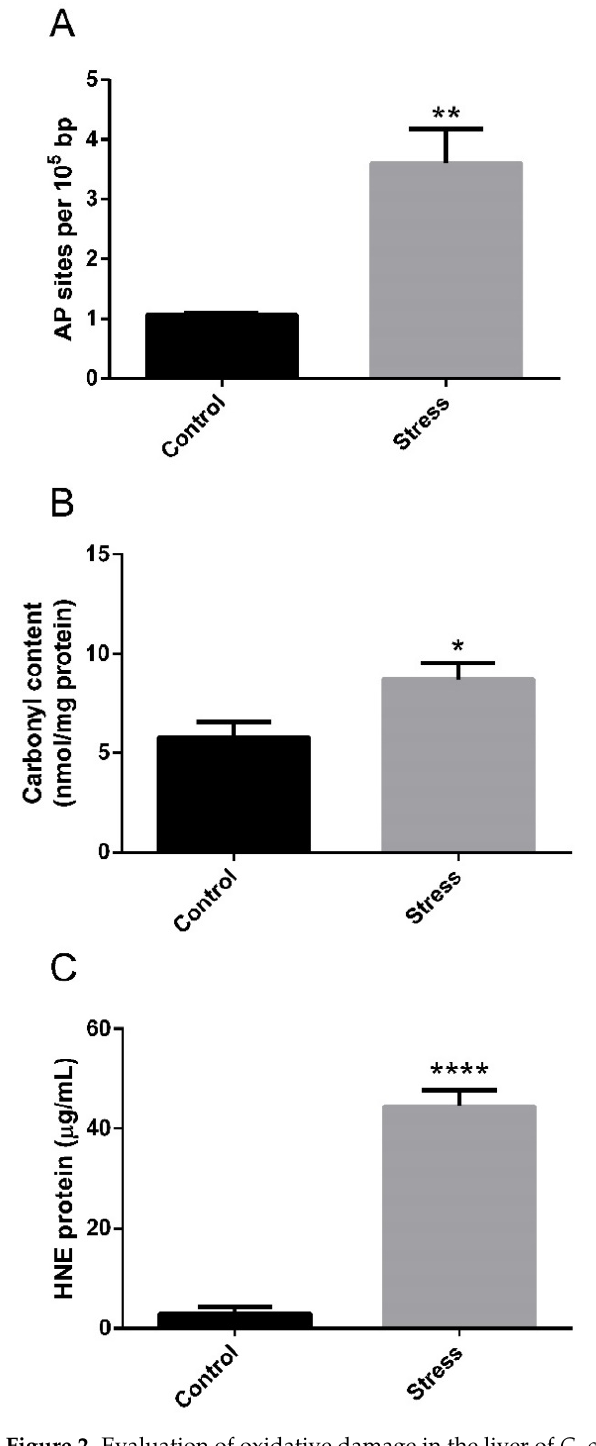
Figure 2. Evaluation of oxidative damage in the liver of G. chilensis in control and high-temperature stress groups. Level of DNA damage in terms of AP sites ( A ), protein carbonylation ( B ), and lipid peroxidation in terms of HNE adducts ( C ) in control and stress groups. Bars represent the mean ± SEM. Significant differences between the control and stress groups are indicated by asterisks; * ( p < 0.05), ** ( p < 0.01) and **** ( p < 0.0001).